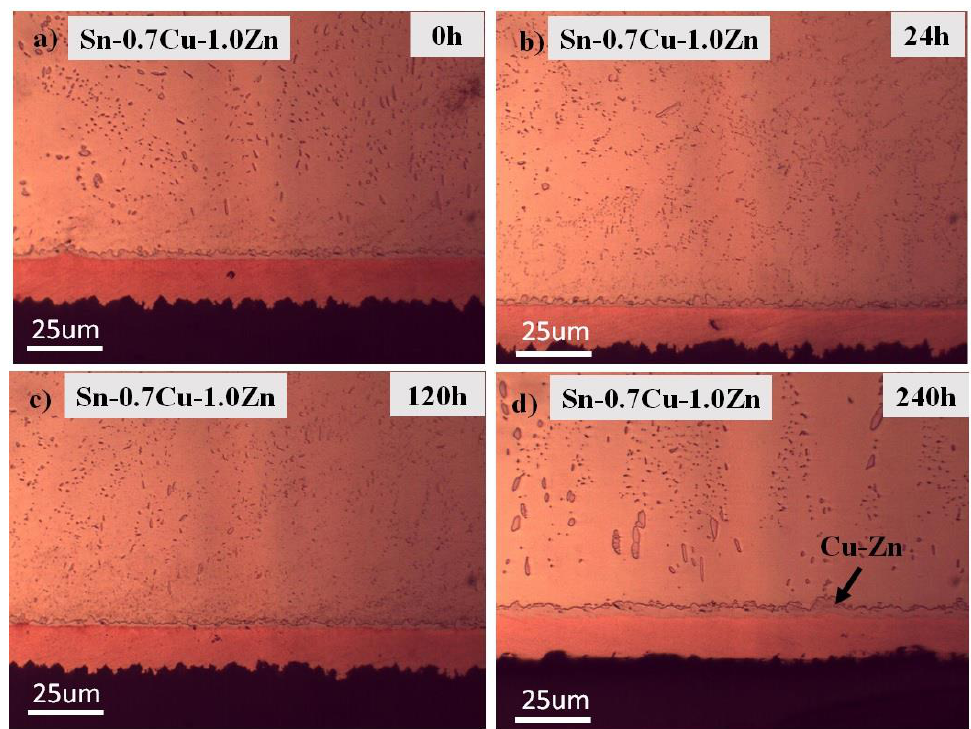
Figure 8. Microstructure of Interfacial IMC of Sn-0.7Cu-0.5Zn after annealing at ( a ) 0 h, ( b ) 24 h, ( c ) 120 h and ( d ) 240 h at 180 °C.